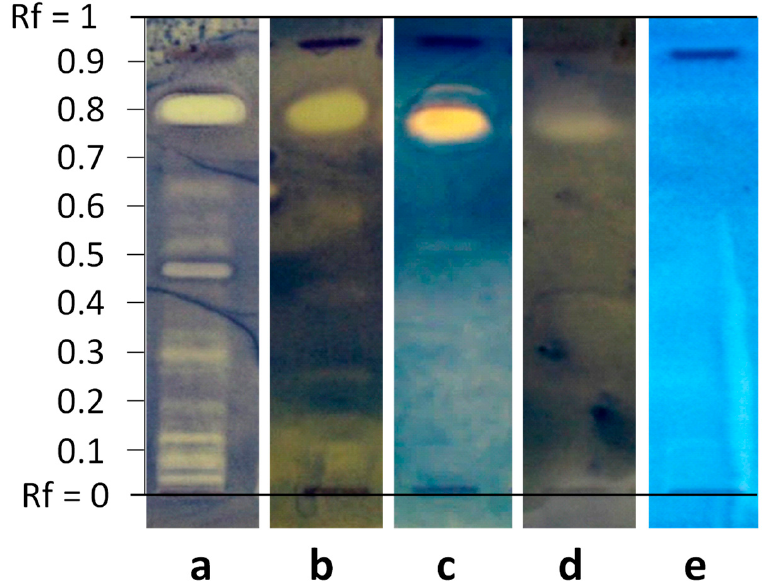
Figure 1. TLC bioautograms obtained with the EtOAc extract from Armillaria cepistipes var. pseudobulbosa against ( a ) E. faecalis ; ( b ) S. aureus ; ( c ) S. epidermidis ; ( d ) E. coli ; ( e ) P. aeruginosa .